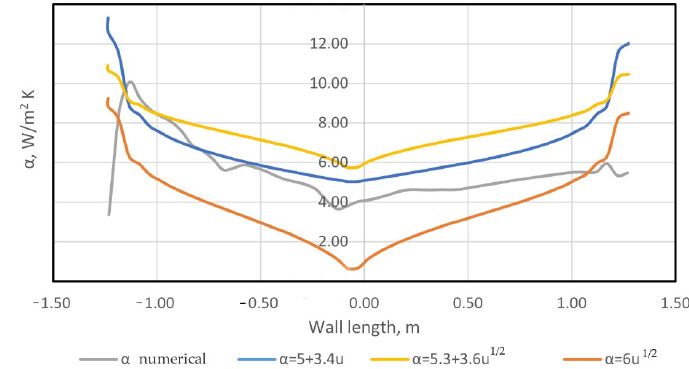
Figure 22. Heat transfer coefficients for the top wall 𝛼 𝑖𝑛 .